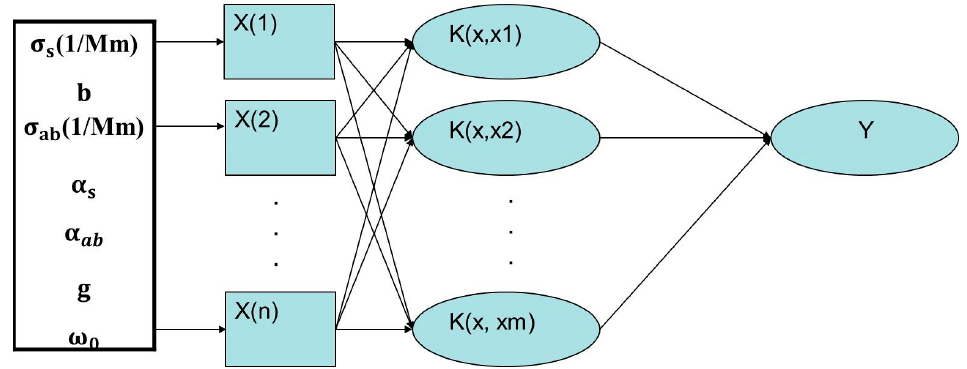
Figure 2. Flow chart of the support vector machine (SVM) in this experiment [37].